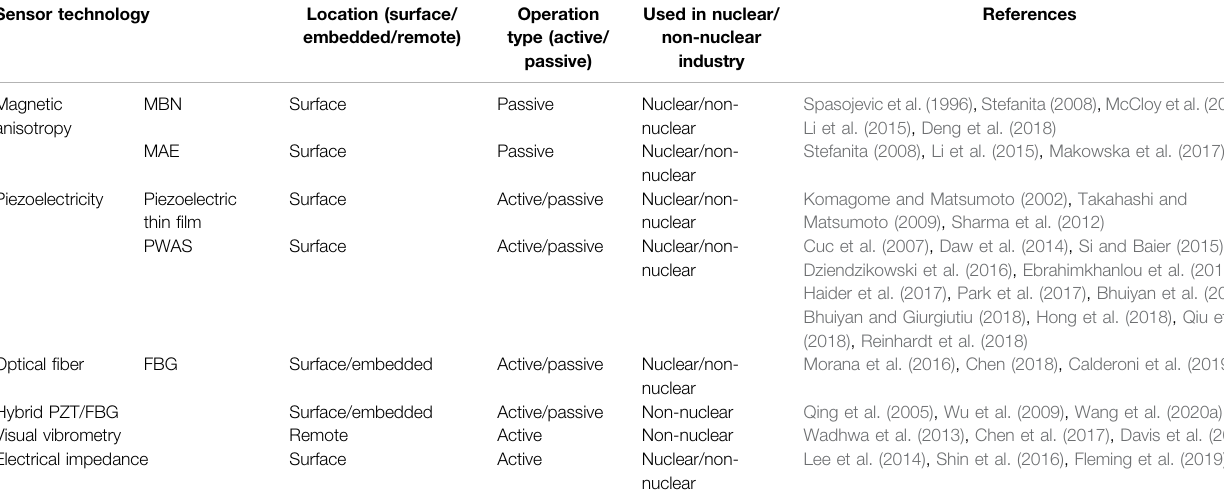
TABLE 1 | Comparison of different sensor technologies. Sensor